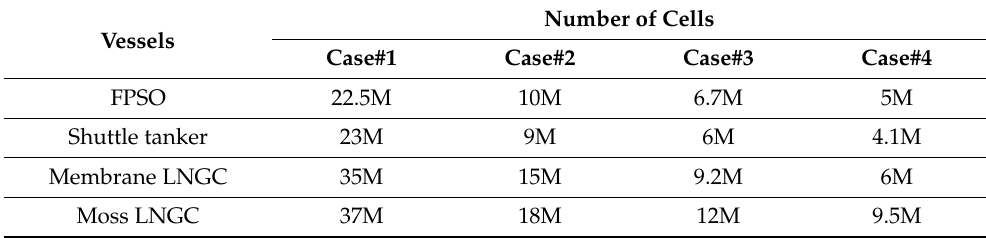
( b ) Figure 6. Residuals 𝐿 2 -norm of the shuttle tanker simulations, α = 0 °. ( a ) finest mesh; ( b ) coarsest mesh. ( b ) Figure 7. Convergence of forces and moments for the membrane-type LNGC, α = 0 °, 30°, 60°, and 90°. ( a ) forces; ( b ) moments.